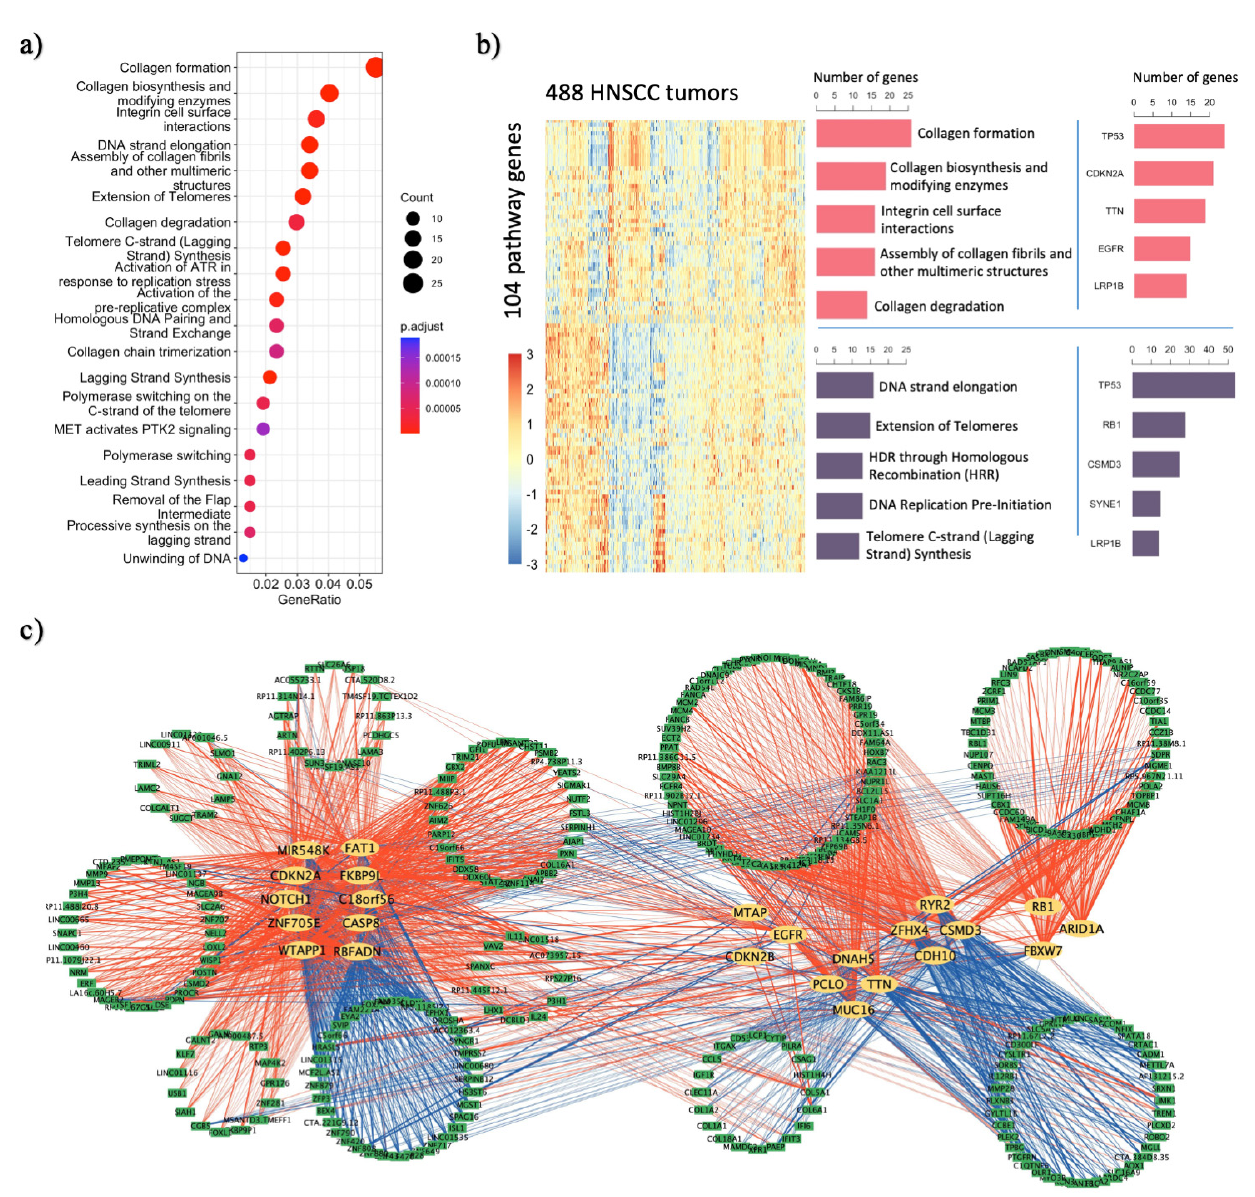
Figure 2. TCI result analysis for HNSCC patients. ( a ) Reactome pathway enrichment analysis of 903 TCI DEGs. Top 20 pathways with highest adjusted p values are listed. ( b ) 104 gene from 59 enriched Reactome pathways can be separated into 2 groups based on their expression profile. Forty-seven genes in the upper part are more associated with collagen biosynthesis processes with TP53 , CDKN2A , TTN , EGFR and LRB1P as their major drivers. Fifty-seven genes in the lower part are more associated with cell cycle and DNA repair processes with TP53 , RB1 , CSMD3 , SYNE1 and LRB1P as their major drivers; ( c ) Driver and DEG causal relationship network. Each yellow node represents a TCI driver and each green node represents a DEG. Each red line represent a driver → DEG activating causal interaction and each blue line represents a repressing driver → DEG causal interaction.